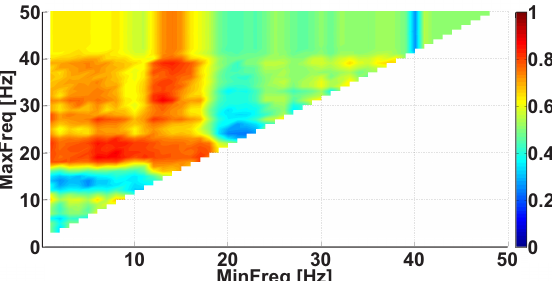
Figure 7. An example of the Frequency AUC diagram. The abscissa axis is the lower bound of the frequency range; the ordinate axis is the upper bound of the frequency range. Two bright red areas are observed. The first red area is situated along the abscissa axis from 0 to 18 Hz; the y-coordinate is equal to approximately 20 Hz. The second area is situated along the ordinate axis from 17 Hz and above; the x-coordinate is equal to approximately 14 Hz. The brightest point corresponds to the human physiological tremor frequency area from 8 to 20 Hz.